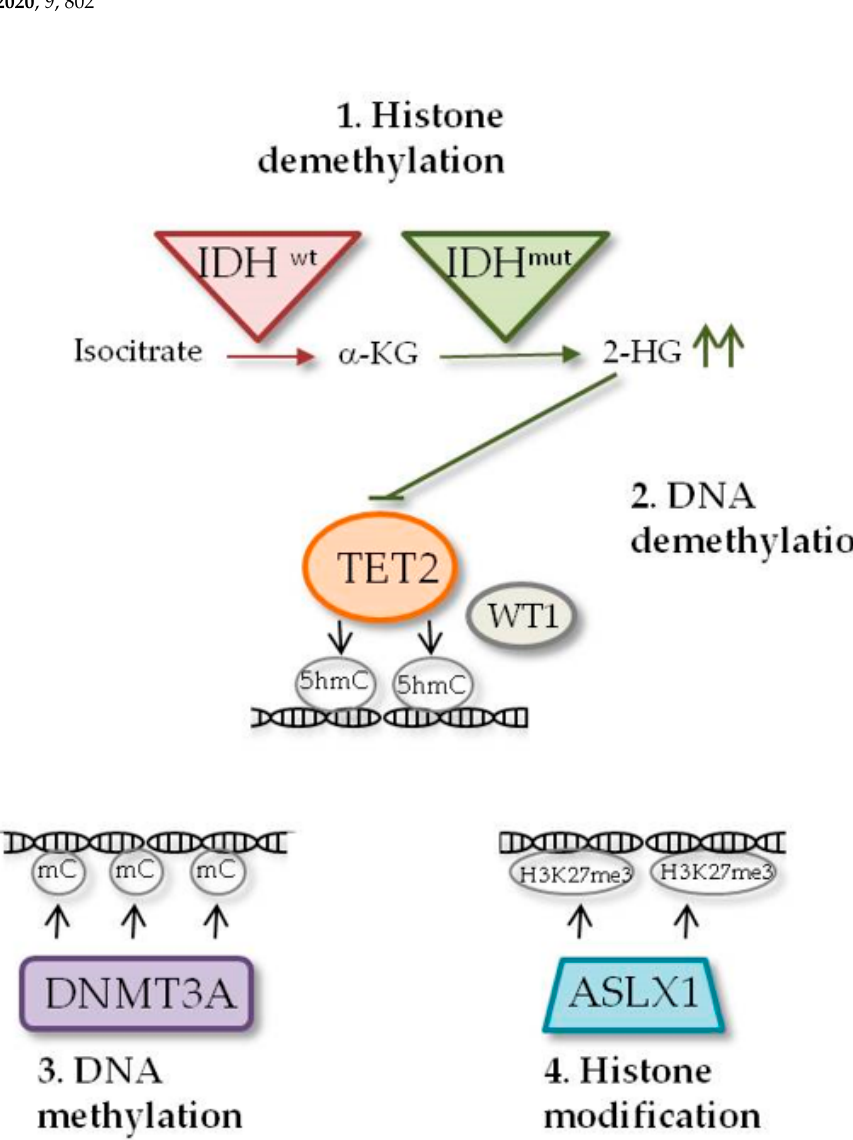
Figure 2. Epigenetic regulators commonly mutated in AML. This scheme highlights the network of proteins involved in epigenetic activity, divided in four epigenetic levels: ( 1 ) histone demethylation, ( 2 ) DNA demethylation, ( 3 ) DNA methylation and ( 4 ) histone modification. In detail, ( 1 ) and ( 2 ) highlight the dynamic interplay between IDH1 / 2, TET2 and WT1: mutated IDH1 and IDH2 inhibit the activity not only of various histone demethylases, but also of DNA demethylase TET2, through the generation of oncometabolite 2-HG, in turn resulting in DNA hypermethylation; mutated TET2 loses the demethylating activity and causes a hypermethylation profile for itself; mutated WT1is unable to interact with TET2, impairing TET2 demethylating activity. ( 3 ) Mutated DNMT3A loses the methyltransferase ability, thus resulting in DNA hypomethylation. ( 4 ) Mutated ASXL1 loses the ability to methylate histone H3 via PRC2 complex, causing a deregulation of key genes involved in stem-cell maintenance and myeloid di ff erentiation. α -KG, α -ketoglutarate; 2-HG, 2-hydroxyglutarate; 5hmC, 5-hydroxymethylcytosine; mC, methylcytosine; H3, histone H3; K27me3, trimethyl at 27th lysine residue.